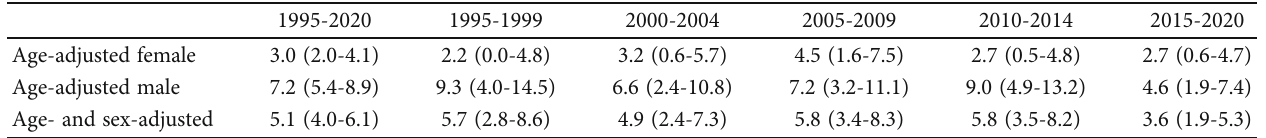
Table 3: Incidence rates of EOGC in Olmsted County, MN, from 1995 to